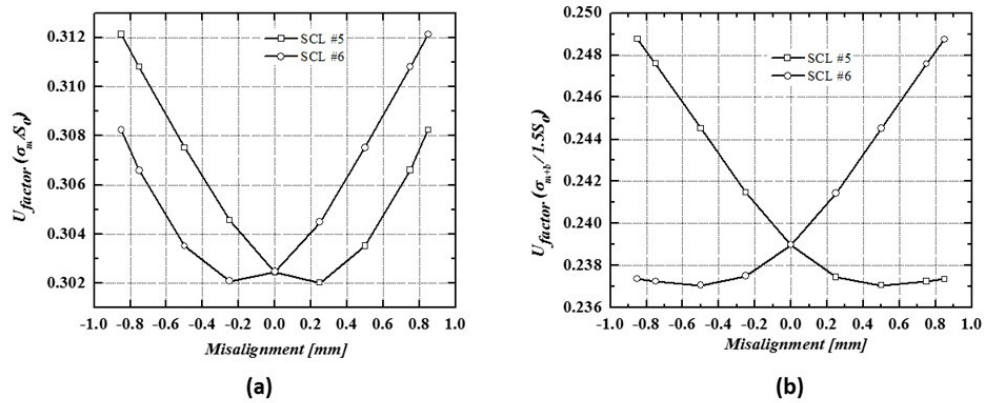
Figure 9. Increase of utilization factor as the increase of the misalignment condition: ( a ) compared to S o ; ( b ) compared to 1.5 S o .